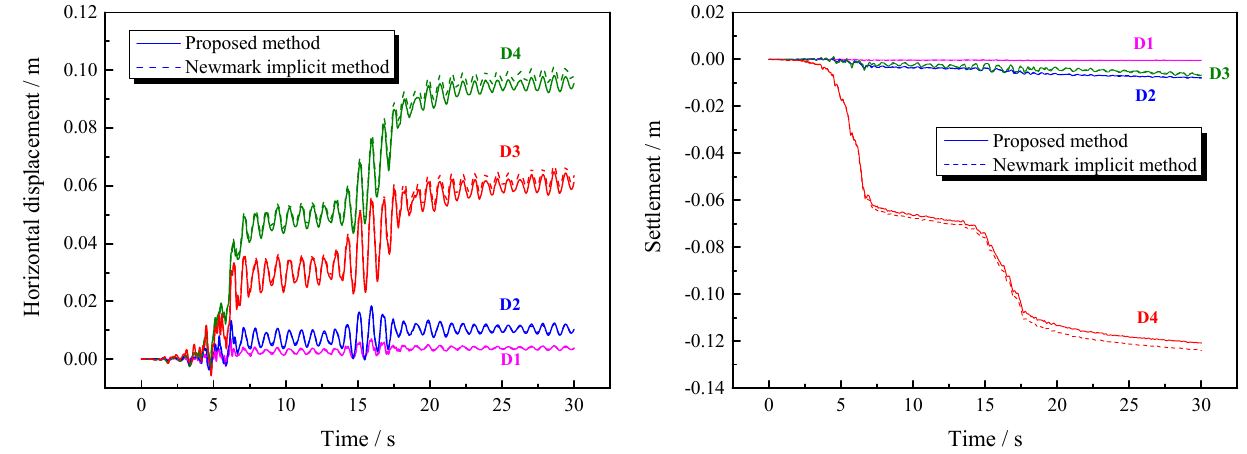
Figure 10. Time history curves of horizontal and vertical displacements at measuring points D1–D4.